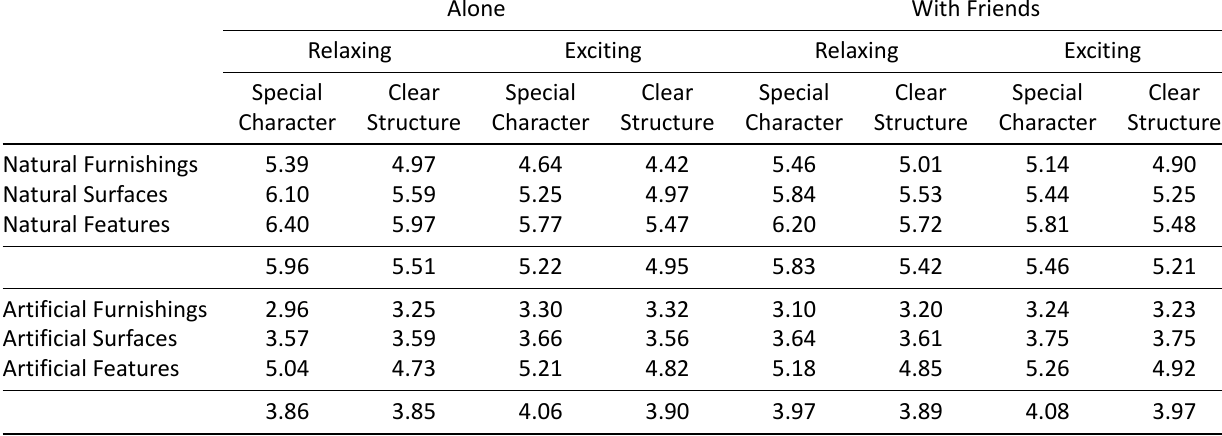
Table 2. Mental image of design elements.